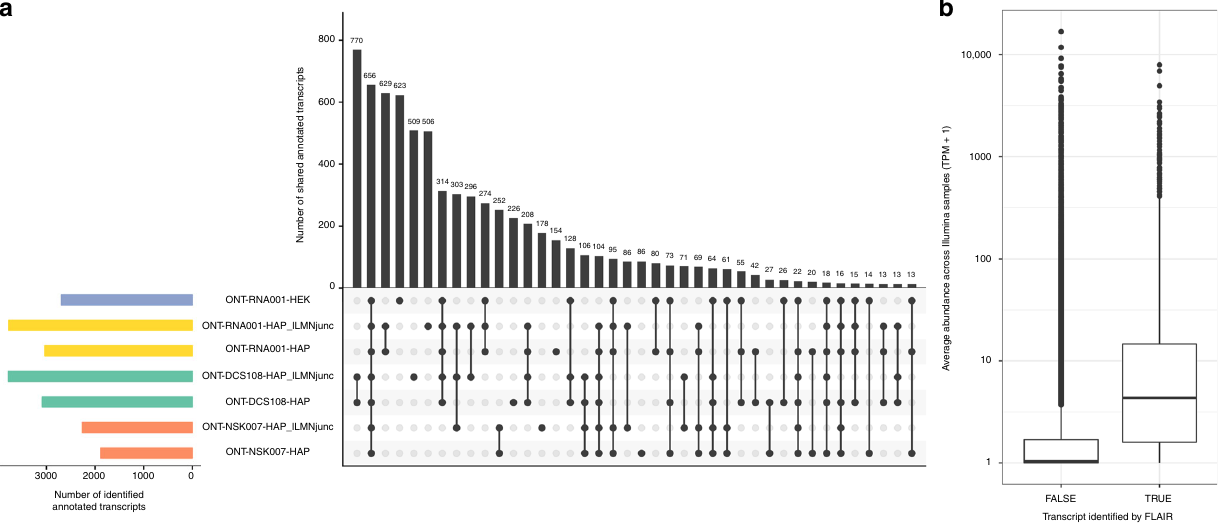
Fig. 7 Comparison of annotated transcripts identi fi ed by FLAIR in the four ONT data sets. a UpSet plot representing overlaps between the annotated transcripts that are identi fi ed by FLAIR in the different ONT data sets. An annotated transcript is considered to be identi fi ed if at least one FLAIR transcript is assigned to it with a structural category annotation of either ‘ full-splice_match ’ or ‘ incomplete-splice_match ’ . These sets of annotated transcripts are then compared between data sets. Horizontal bars indicate the total number of identi fi ed annotated transcripts in the respective data sets, and vertical bars represent the size of each intersection of one or more sets of identi fi ed transcripts. b Average abundance across the Illumina samples, for annotated transcripts that are considered identi fi ed or not by FLAIR. An annotated transcript is considered to be identi fi ed if at least one FLAIR transcript from at least one data set is assigned to it with a structural category annotation of either ‘ full-splice_match ’ or ‘ incomplete-splice_match ’ . The center line represents the median; hinges represent fi rst and third quartiles; whiskers the most extreme values within 1.5 interquartile range from the